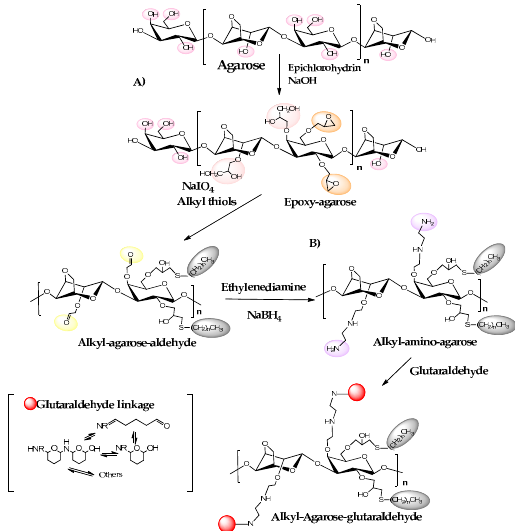
Figure 4. Schematic representation of the preparation of heterofunctional supports. ( A ) Preparation of new tailor-made alkyl-aldehyde supports; ( B ) glutaraldehyde-activation of alkyl-aldehyde support.